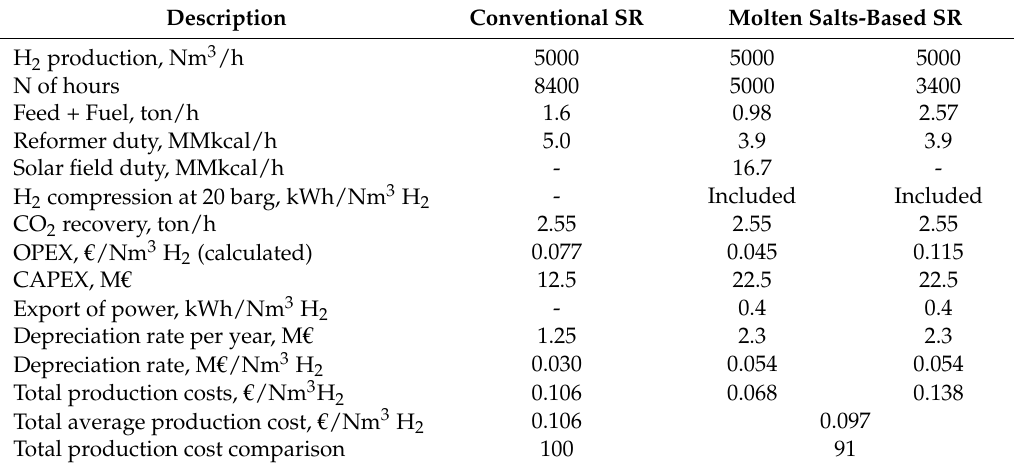
Table 4. Cost of production (COP) of H 2 for the conventional scheme and molten salts-based steam reforming.